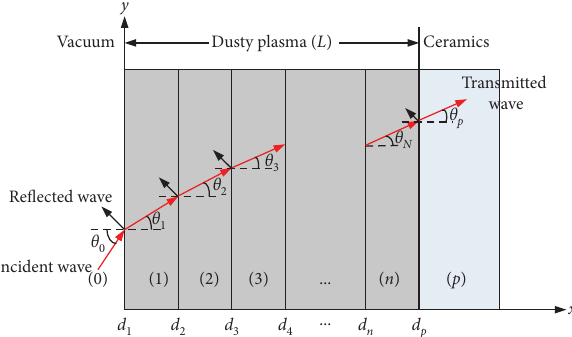
Figure 1: Schematic diagram of the propagation of a THz wave with the oblique incidence in dusty layered